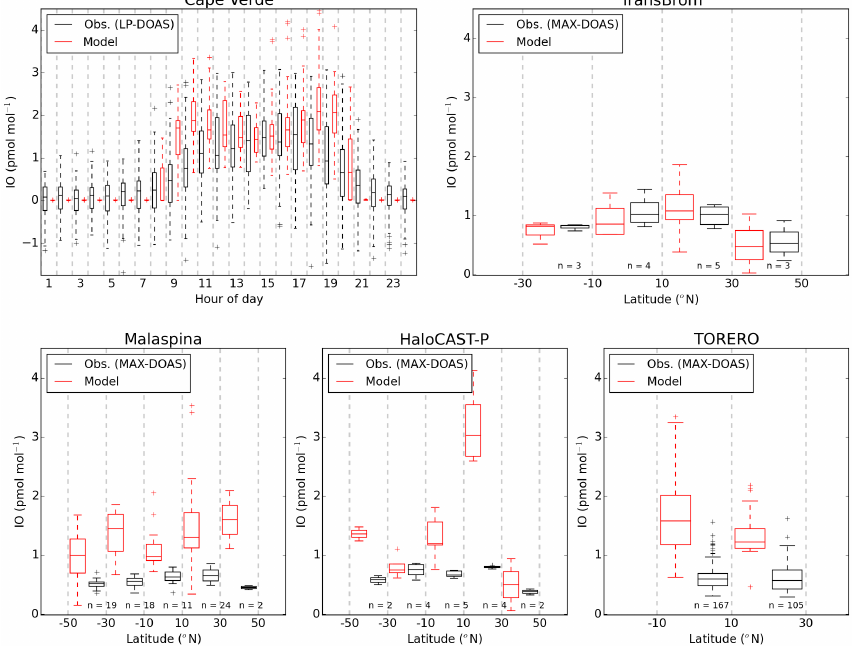
Figure 5. Iodine oxide (IO) surface observations (black) by campaign compared against the simulation with both iodine and bromine chem- istry (“Br + I”, red). Cape Verde measurements are shown against hour of day and others are shown as a function of latitude. Values are considered in 20 ◦ bins, with observations and modelled values at the same location and time (as described in Sect. 2) shown side-by-side around the mid-point of each bin. Extents of bins are highlighted with grey dashed lines. Observations are from Cape Verde (Tropical Atlantic, Mahajan et al., 2010; Read et al., 2008), Transbrom (West Pacific, Großmann et al., 2013), the Malaspina circumnavigation (Prados-Roman et al., 2015b), HaloCAST-P (East Pacific, Mahajan et al., 2012), and TORERO ship (East Pacific, Volkamer et al., 2015). Number of data points within latitudinal bin are shown as “ n ”. The boxplot extents give the inter-quartile range, with the median shown within the box. The whiskers give the most extreme point within 1.5 times the inter-quartile